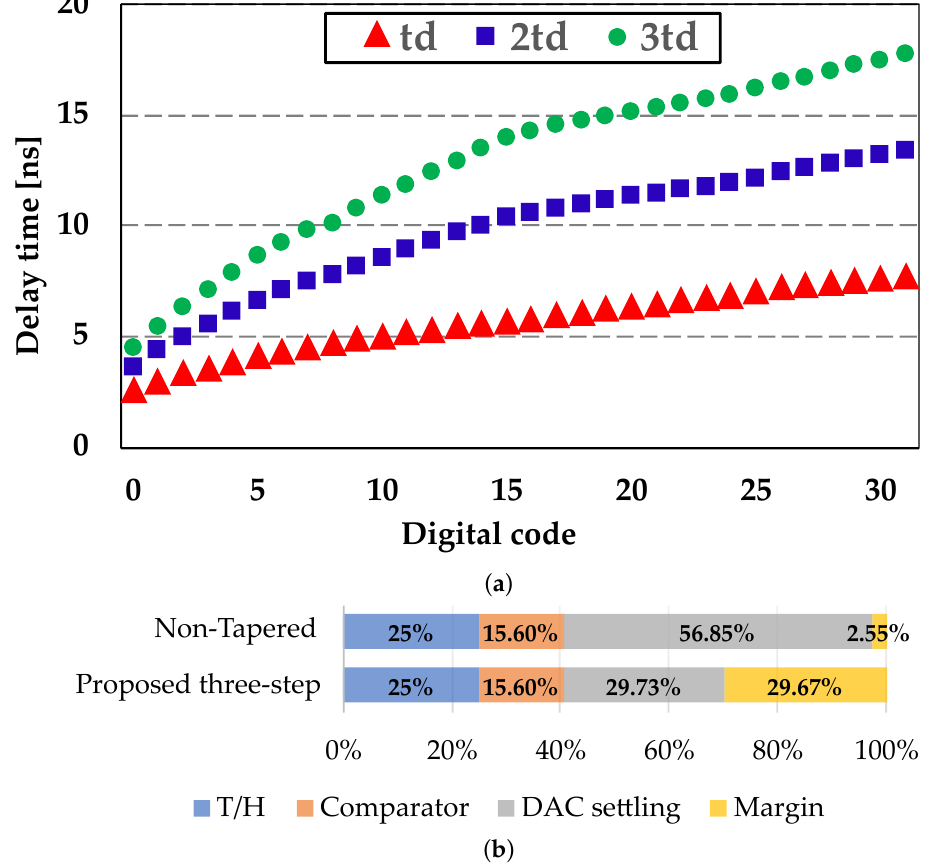
Figure 13. ( a ) Post-simulation result with three-step tapered bit period clock generation according to digital code, ( b ) timing allocation when R ref = 400 Ω in 6 MS/s SAR ADC.